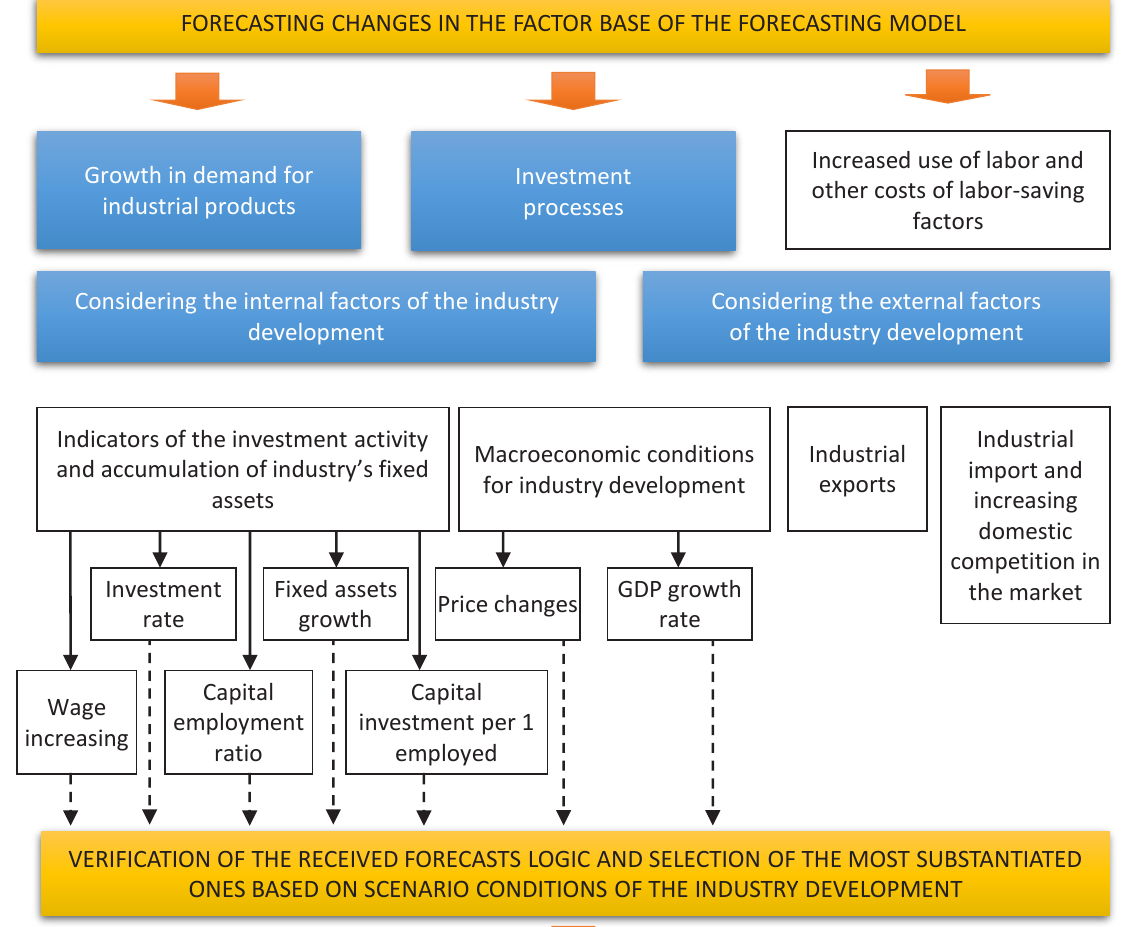
Figure 2. The scheme of new workplaces forecasting in